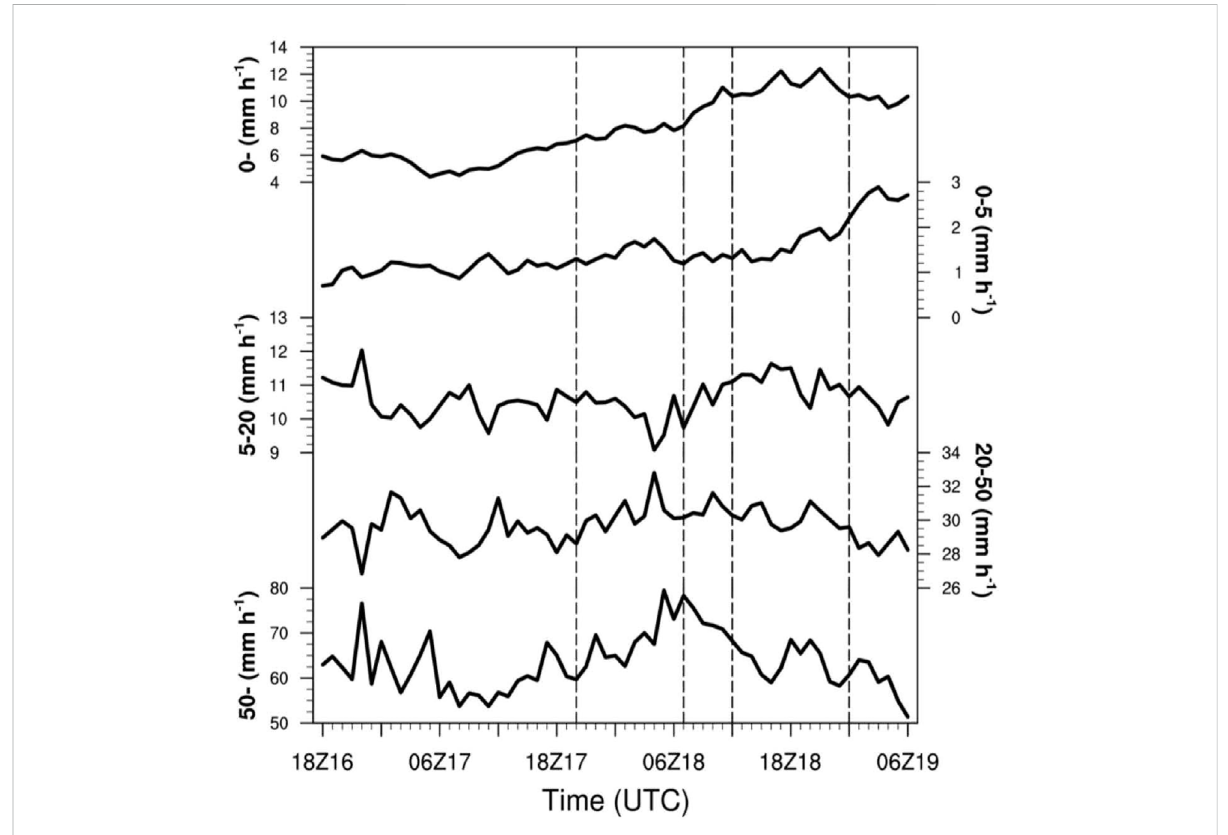
FIGURE 5 It is similar to Figure 3, but for the hourly rainfall intensity (units: mm h − 1